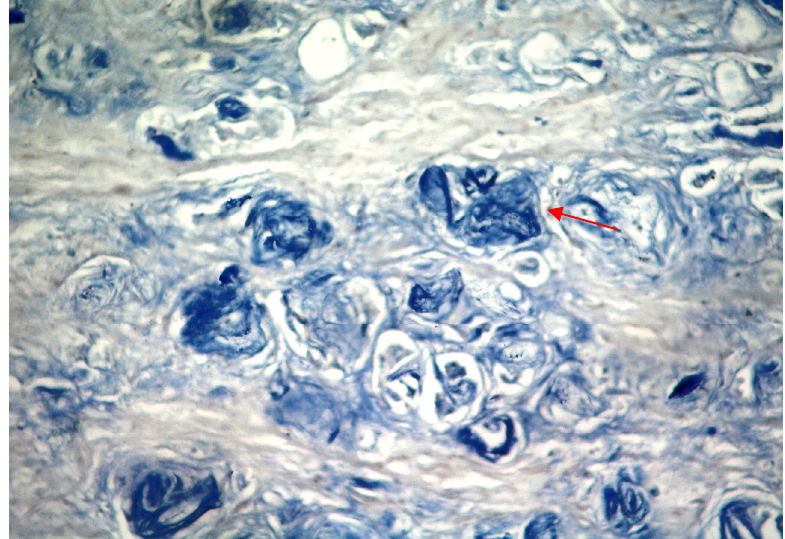
Figure 1. Photomicrograph showing strong VEGF-C mRNA expression in cells of prostate cancer tissue, with positively-stained granules in the cytoplasm and nucleolus of tumor cells ( in situ hybridization, magnification